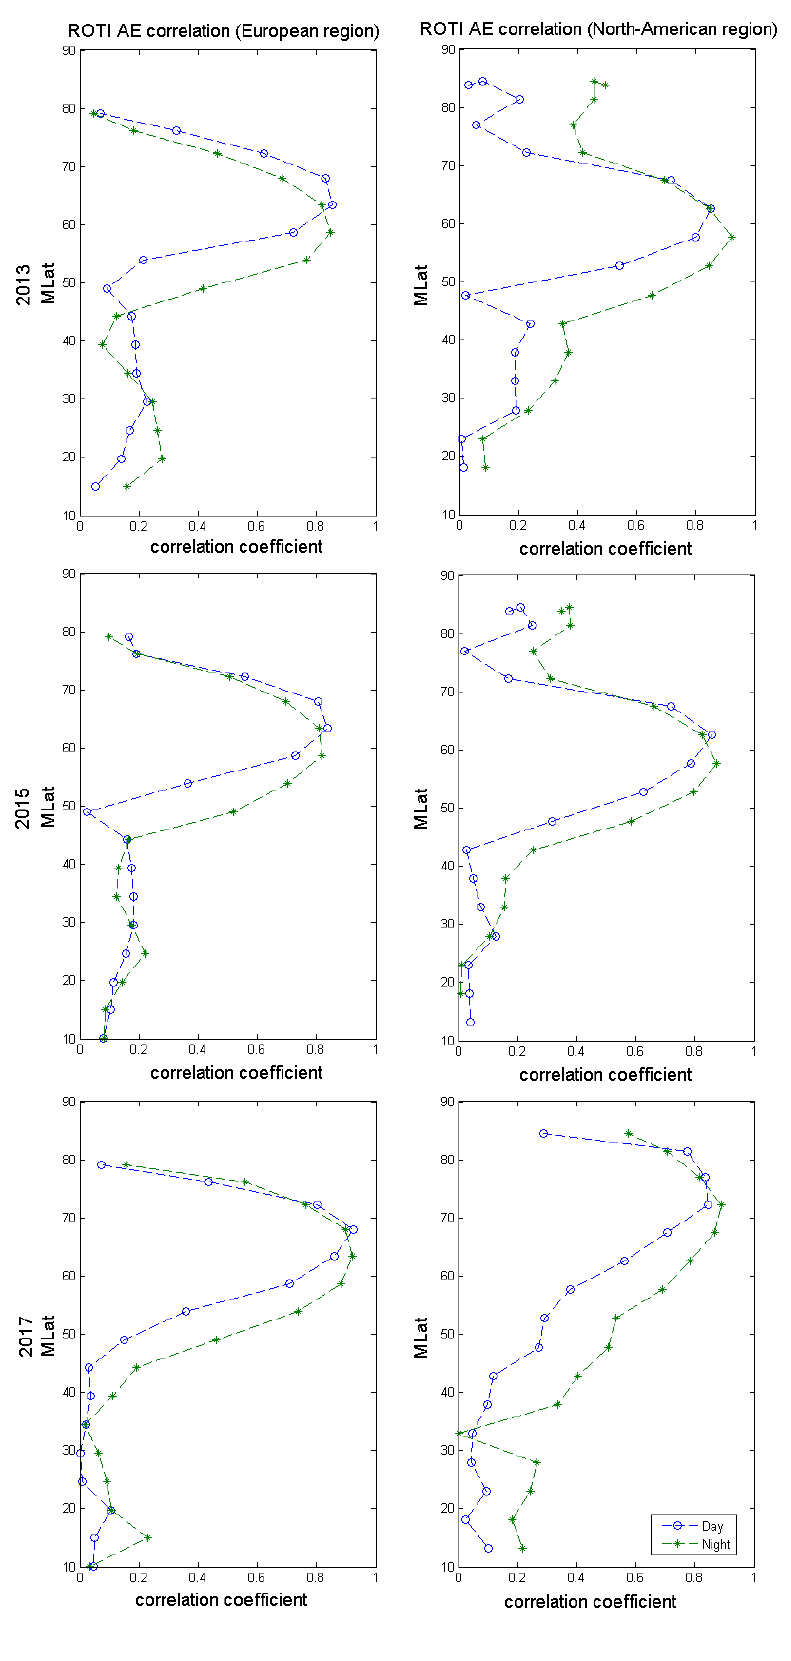
Figure 12. Linear correlation coefficient values between ROTI and AE indexes on different magnetic latitudes in European and North-American sectors in years 2013, 2015 and